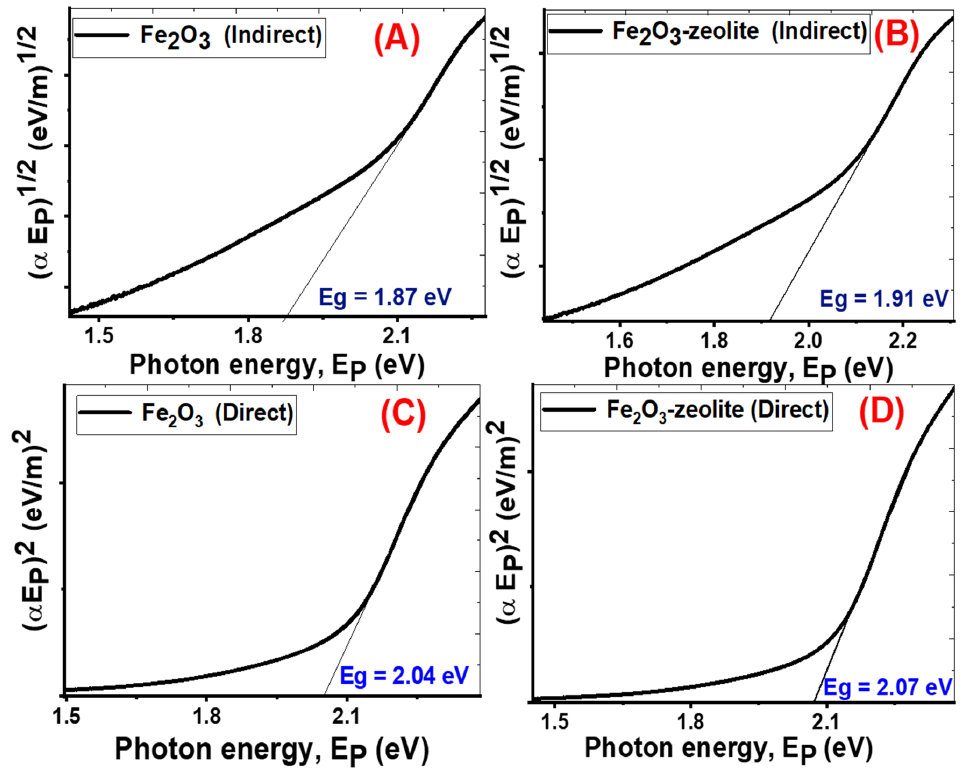
Figure 6. Indirect energy gap ( A , B ) for Fe 2 O 3, and Fe 2 O 3 /zeolite and direct energy gap ( C , D ) for Fe 2 O 3, and Fe 2 O 3 /zeolite, respectively.